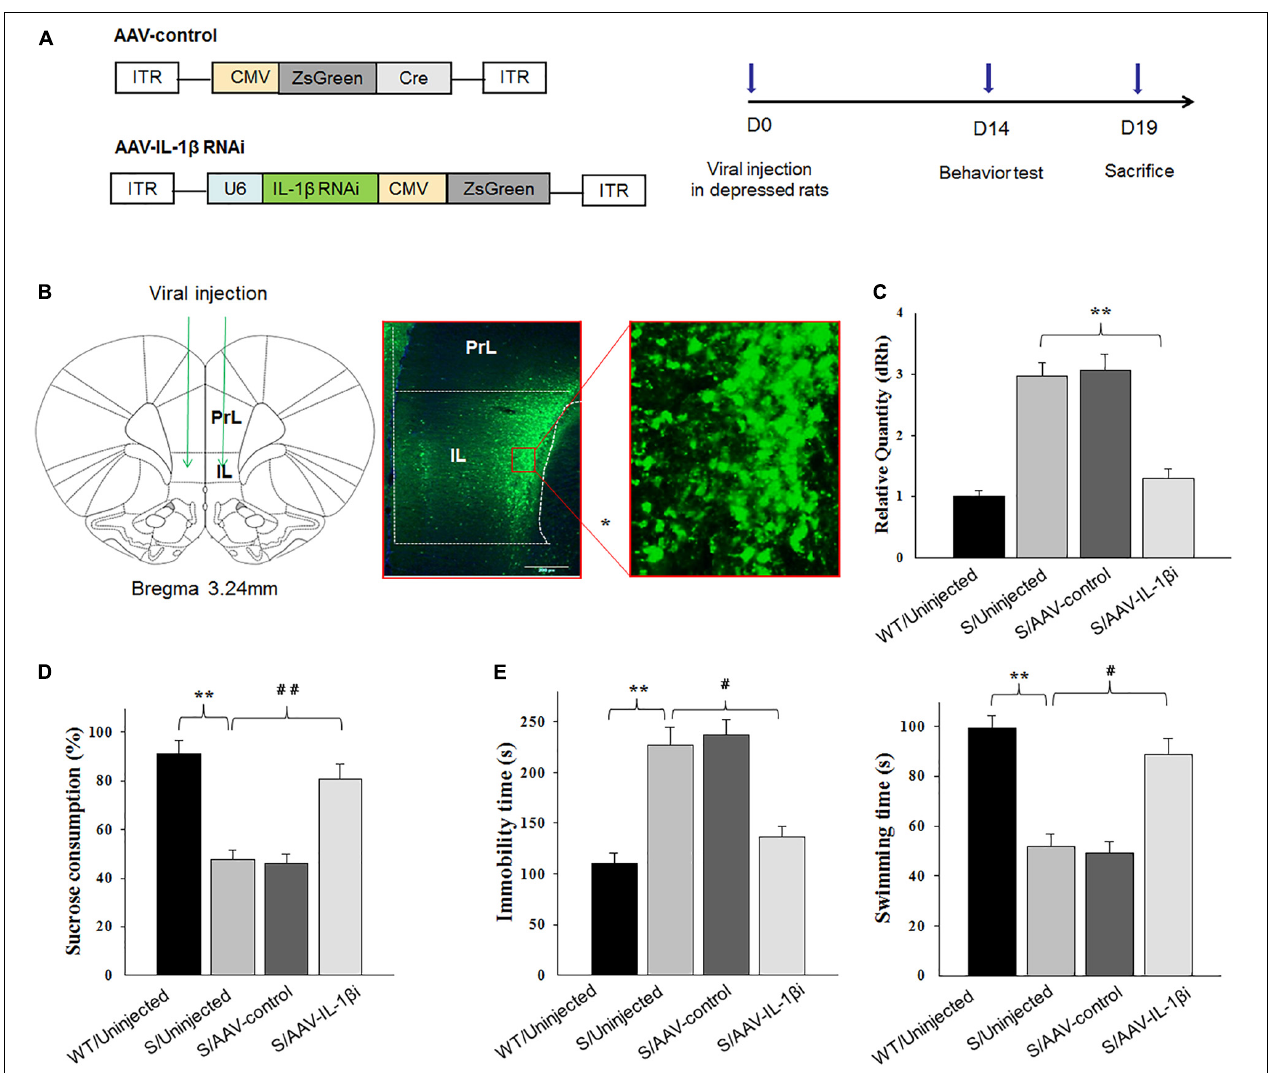
FIGURE 7 | Knocking-down of IL-1 β in the vmPFC reduced depression-like phenotypes of stressed rats. In these experiments, prior to virus infusion, rats experienced a 5-week period of CUMS exposure to induce depression-like phenotypes. (A) Left: Schematics of AAV vectors engineered to overexpress a control construct or RNAi form of IL-1 β . U6, IL-1 β shRNA promoter. Right: Experimental paradigm for behavioral testing of rats infected with the virus. (B) Illustration of viral infusion of the IL-1 β RNAi construct into the vmPFC. Scale bar is 100 µ m. (C) Estimation of β CaMKII overexpression efficiency after viral constructs injection. (D,E) Behavioral effects of expressing AAV-IL-1 β RNAi construct within the vmPFC of stressed rats. N = 12 in all groups. ∗ P < 0.05, ∗∗ P < 0.01, ∗∗∗ P < 0.001 Stressed rats vs. WT rats. # P < 0.05, ## P < 0.01, ### P < 0.001 S+AAV-IL-1 β RNAi vs. Stressed rats (S,